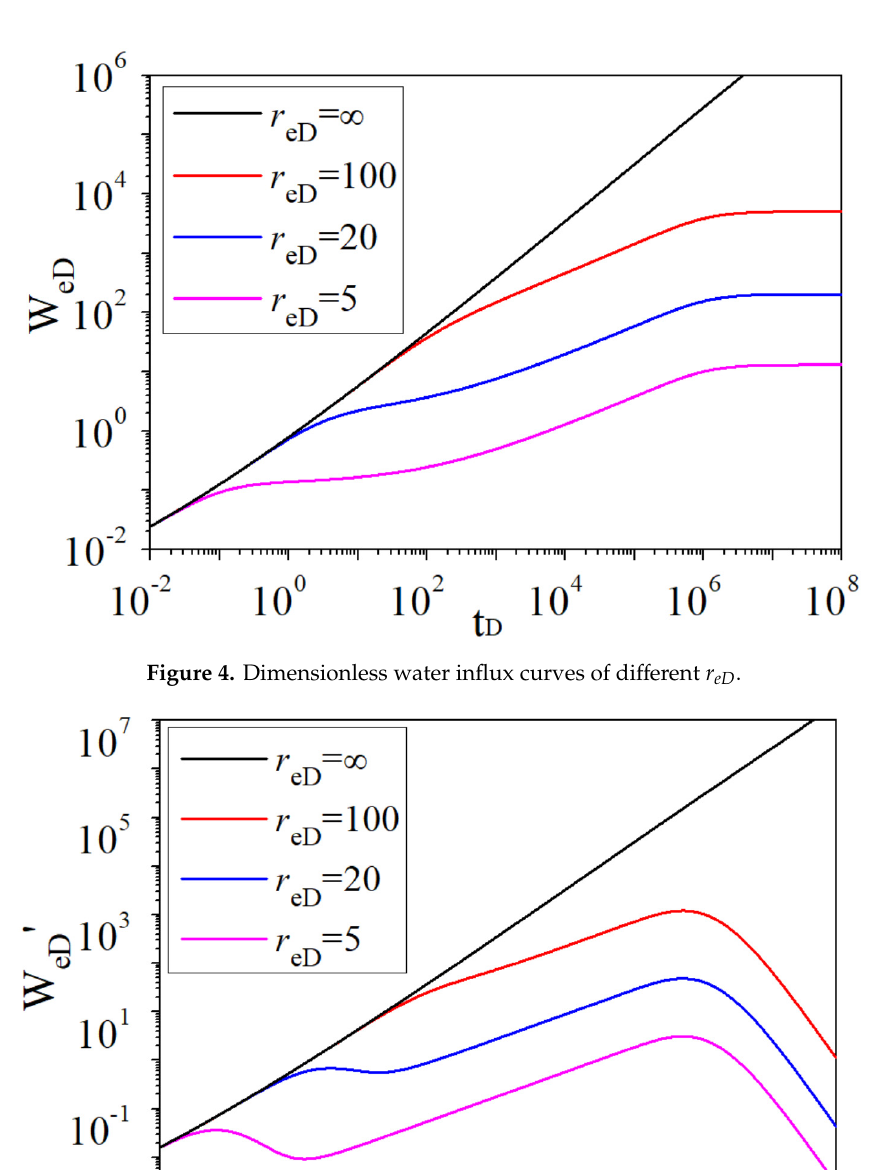
r . Figure 5. Dimensionless water influx derivative curves of di ff erent r eD eD r . eD